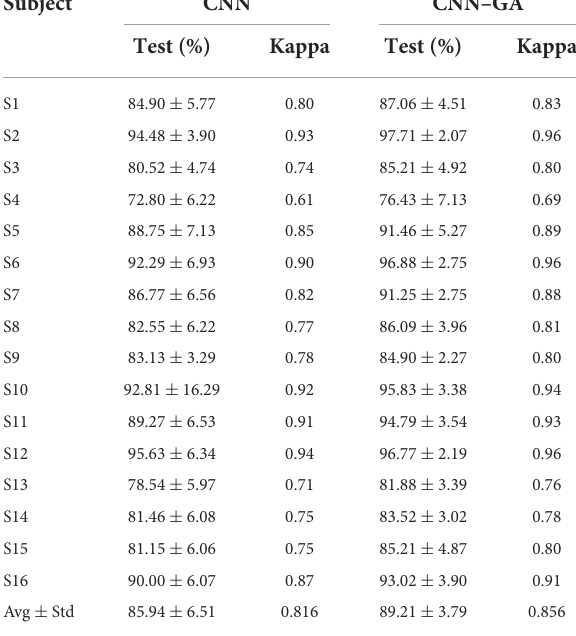
TABLE 2 Averaged accuracies for each subject under the CNN and CNN–GA